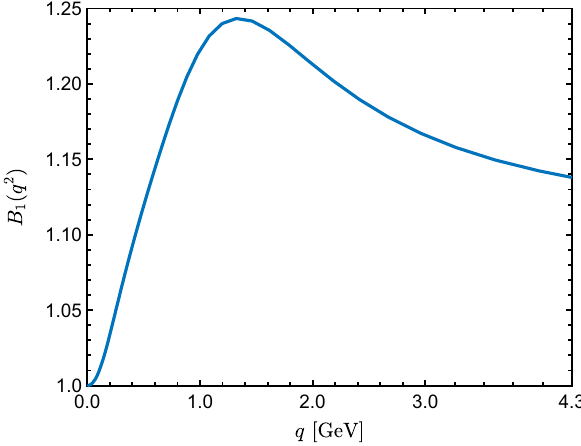
Fig. 2 The ghost-gluon vertex form factor, B 1 ( q 2 ) , given by Eq. (5.2)